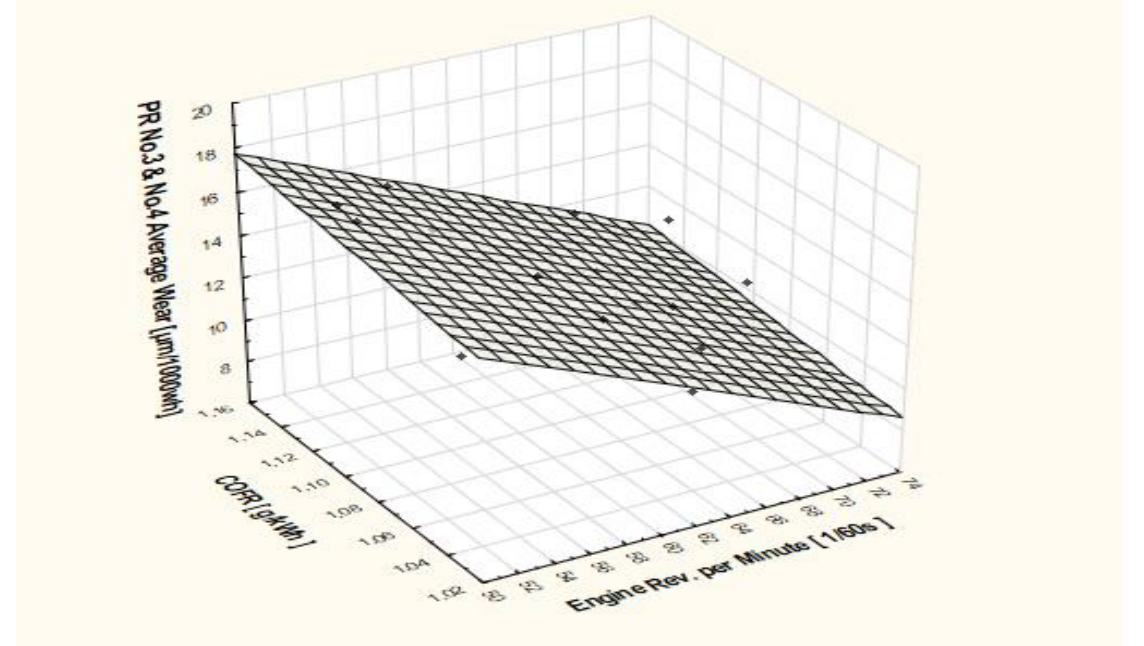
Figure 5. Results of average wear rates for PR No. 3 and 4 in all engine units, depending on COFR and the engine’s RPM (piston speed).